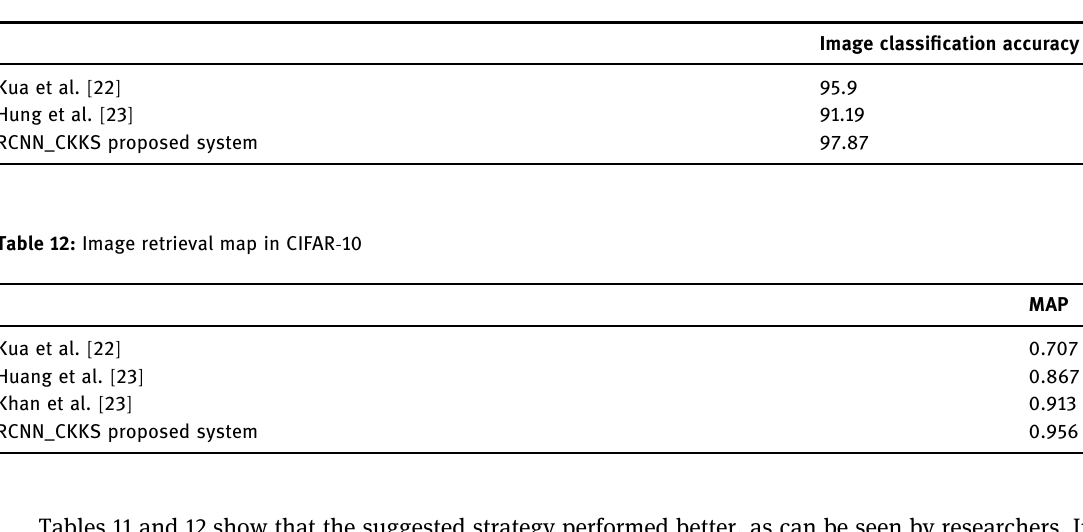
Table 11: Image classi fi cation accuracy in CIFAR - 10